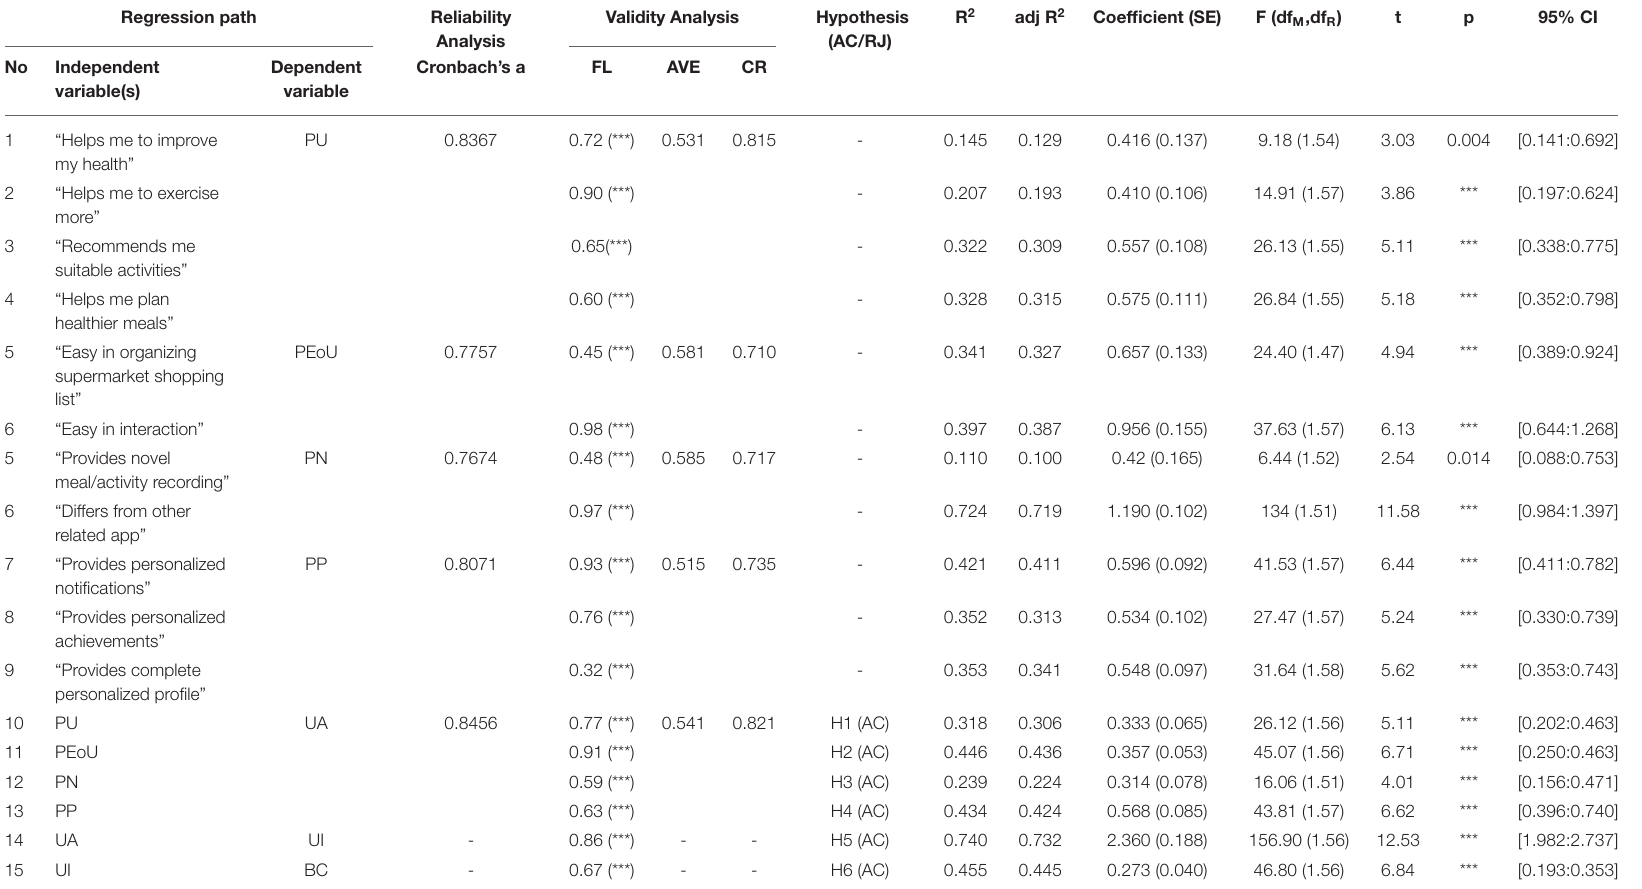
TABLE 1 | Reliability, validity and least squares regression analysis results for the adopted mTAM model ( Figures 2 , 3